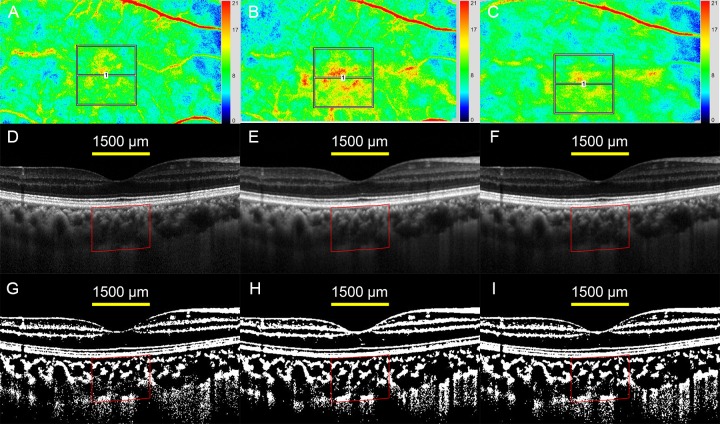
Two-dimensional color mappings of MBR in laser speckle flowgraphy (LSFG), enhanced depth imaging optical coherence tomographic (EDI-OCT) images, and converted binary images of a healthy 45-year-old woman.(A, B, C) LSFG images at baseline (A), immediately after the exercise (B), and 10 minutes after the exercise (C). A false-color composite map at the macula was created using the LSFG software. The red area indicates a faster blood flow, and the blue area indicates a slower blood flow. The average MBR was 9.3 (arbitrary unit) at the baseline which increased to 11.4 at immediately after the exercise, and then decreased to 9.7 at 10 minutes after the exercise. (D, E, F) EDI-OCT images at baseline (D), immediately after the exercise (E), and 10 minutes after the exercise (F). (G, H, I) The converted binary images of the EDI-OCT images shown in D (G), E (H), and F (I). The choroidal thickness and choroidal area did not change before and after the exercise.